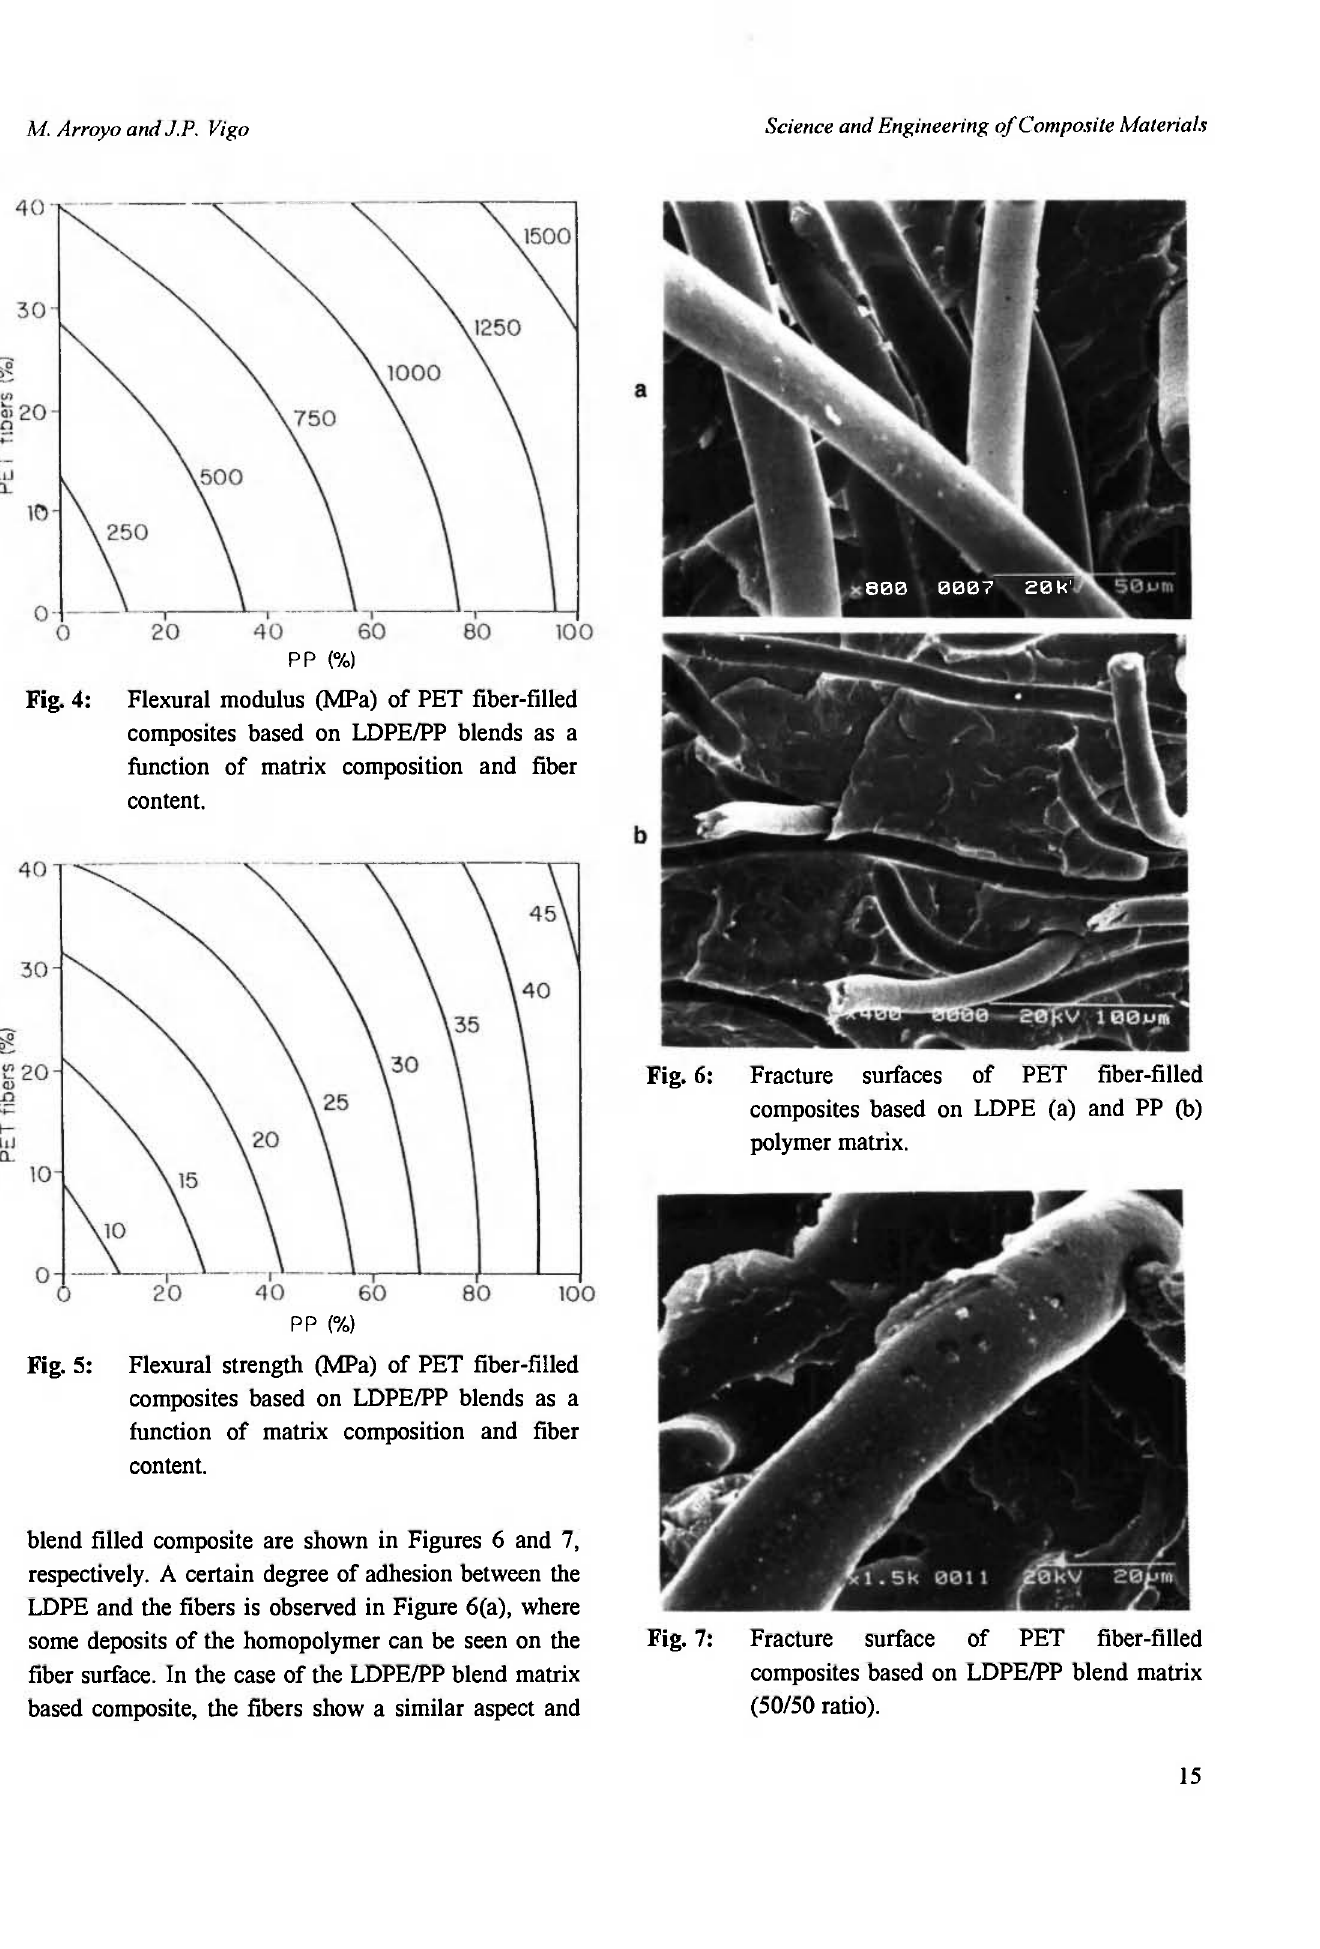
Ρ Ρ (%) Fig. 5: Flexural strength (MPa) of PET fiber-filled composites based on LDPE/PP blends as a function of matrix composition and fiber content.